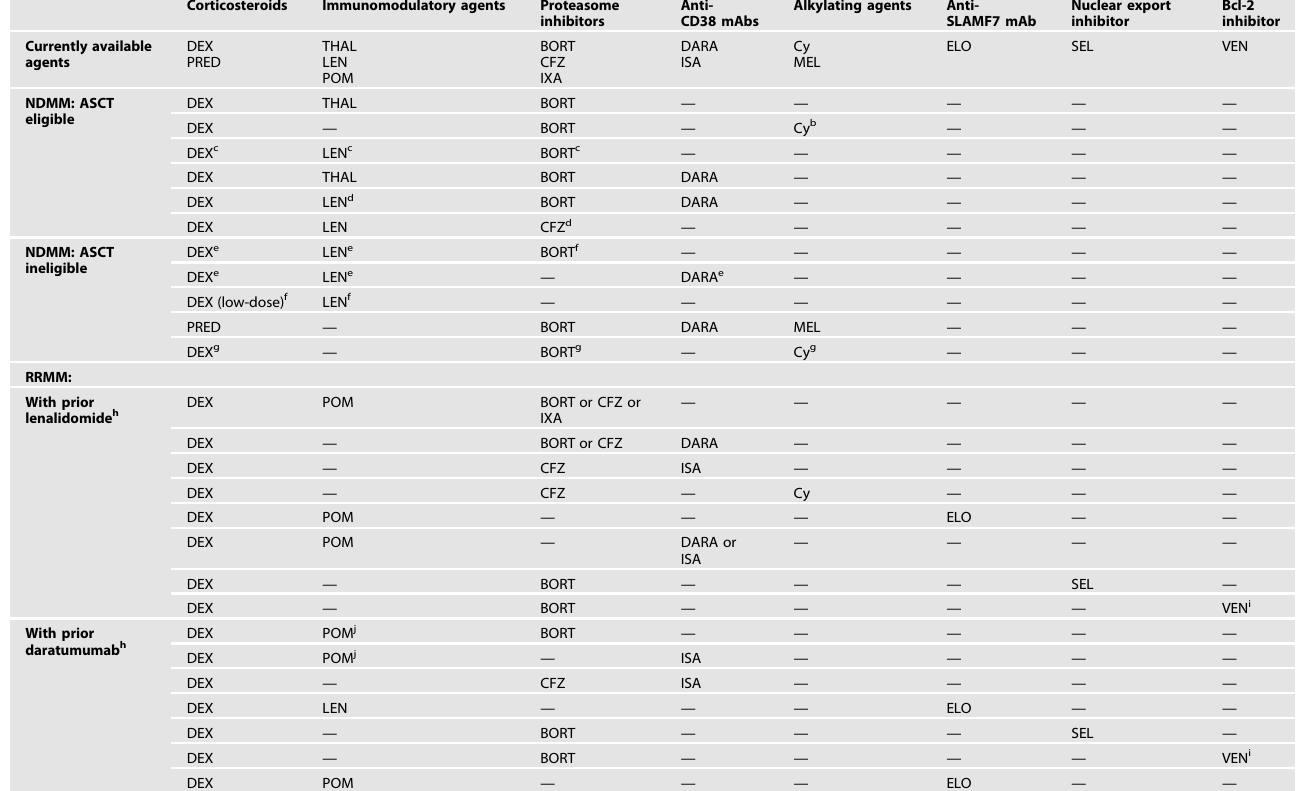
Table 1. Current standard of care regimens in multiple myeloma a